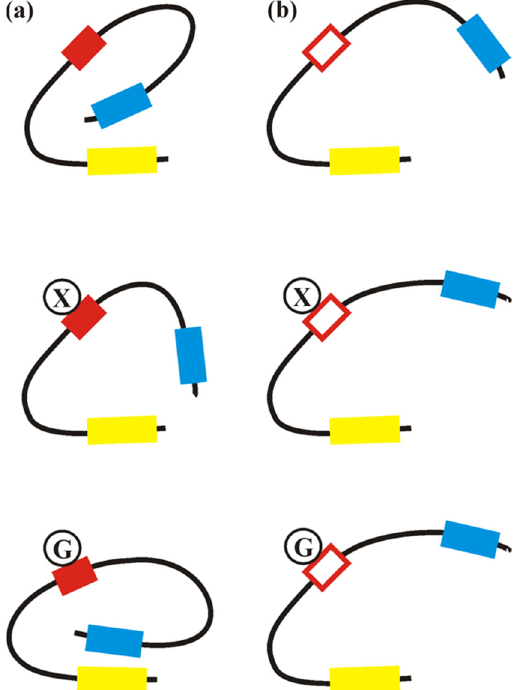
Figure 5. Schematic presentation of the allosteric response of Xyr1 variants. A simplified model of the structure of the wild-type Xyr1 ( a ) and the Xyr1 A824V ( b ) without carbohydrates and their conformational change in the presence of D-xylose (X) or D-glucose-6-phosphate (G), respectively, is presented. Yellow box, DNA-binding domain; red box, NR-like domain; red-framed box, NR-like domain bearing the A824V mutation; blue box, transactivating domain.